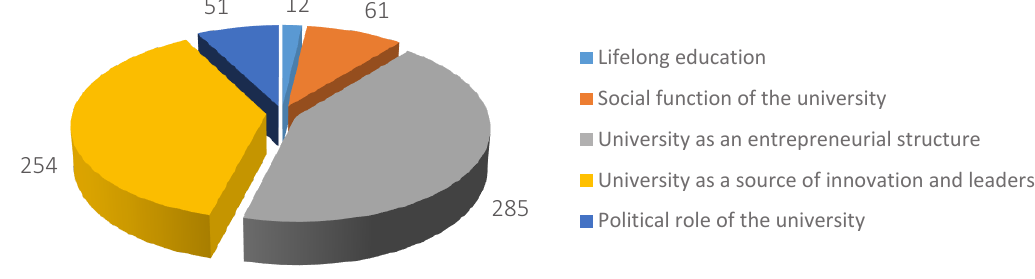
Figure 5. Percentage distribution of research on the third